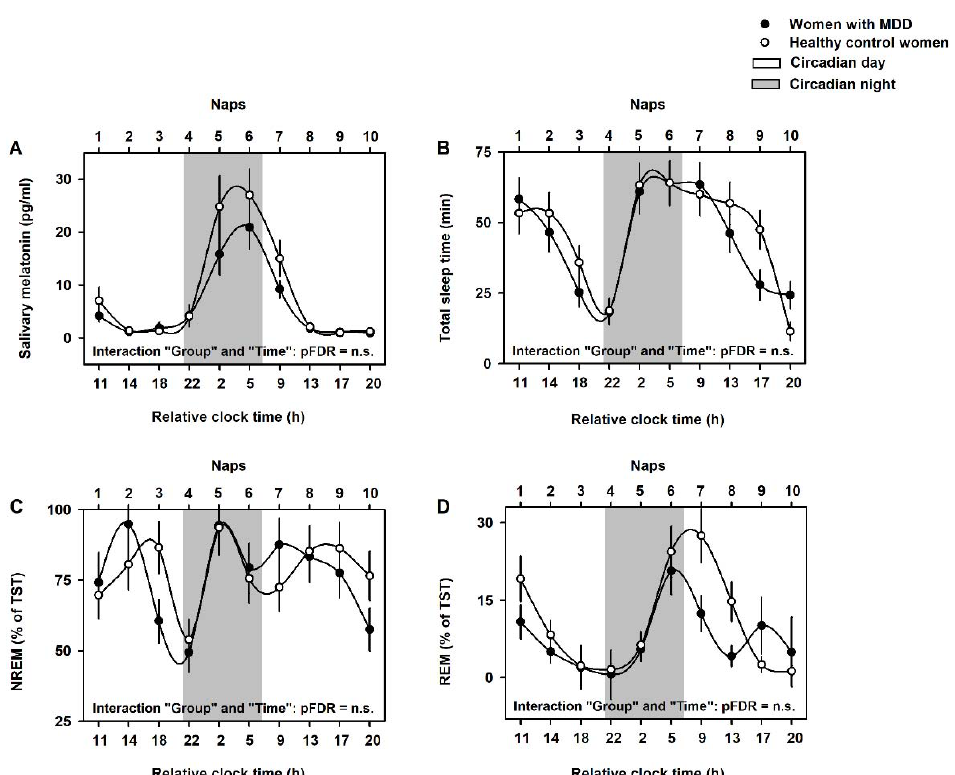
Figure 3. Endogenous circadian melatonin levels and sleep structure during the 40 h multiple nap protocol. We observed no significant interaction effects of “Group” and “Time” for the endogenous melatonin average levels ( A ), total sleep time (TST) ( B ), NREM sleep ( C ), nor for REM sleep ( D ). Data correspond to the mean and standard error of the mean (SEM). Black circles are the average data for women with MDD, and white circles are the average data for the healthy control women. Grey bars correspond to the naps during the circadian night (between ~22:00 h and ~05:00 h). Mixed ‐ model analyses of variance of dream recall and the number of dreams yielded no significant differences for the effects of “Group”, “Circadian day/night” nor for the